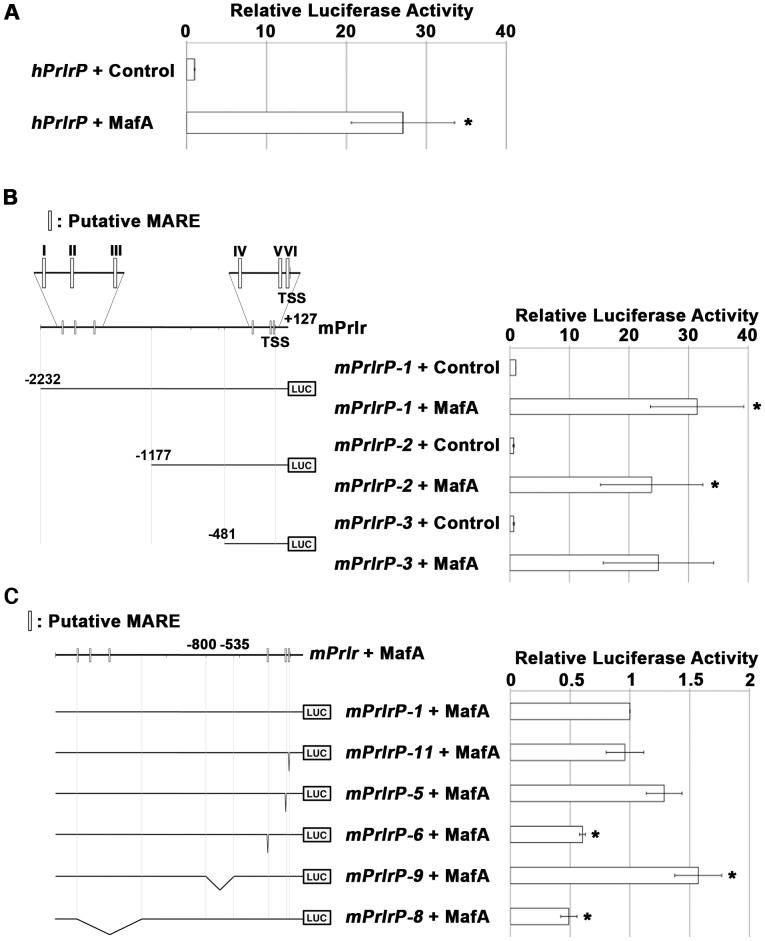
Activation of the Prlr promoter by MafA.The effects of MafA expression on Prlr promoter activity were analyzed using HeLa cells. (A) Luciferase activity driven by the hPrlr promoter (from −890 to +103) in MafA-overexpressing cells compared to control cells transfected with the control vector pcDNA3.1. n = 8. (B) Luciferase activities driven by the mPrlr promoter constructs, including −2232 to +127 (mPrlrP-1), −1177 to +127 (mPrlrP-2) and −481 to +127 (mPrlrP-3), with or without overexpression of MafA, relative to the luciferase activity of mPrlrP-1 with control. n = 5. Six putative MAREs were observed in the mPrlr promoter and are referred to as region I (from −2026 to −2016), region II (from −1907 to −1897), region III (from −1723 to −1713), region IV (from −217 to −207), region V (from −47 to −37) and region VI (from −12 to −2). TSS: transcription start site. (C) Luciferase activities of the mPrlrP-1 construct (−2232 to +127) with MafA compared to the luciferase activities of constructs with deletions in the following regions: region VI (from −12 to −2, mPlrlP-11), region V (from −47 to −37, mPlrlP-5), region IV (from −217 to −207, mPlrlP-6), from −800 to −535 (mPlrlP-9) or regions I to III (from −2026 to −1409, mPlrlP-8). n = 4. The data represent the mean ± S.E.M. Asterisks means p<0.05.